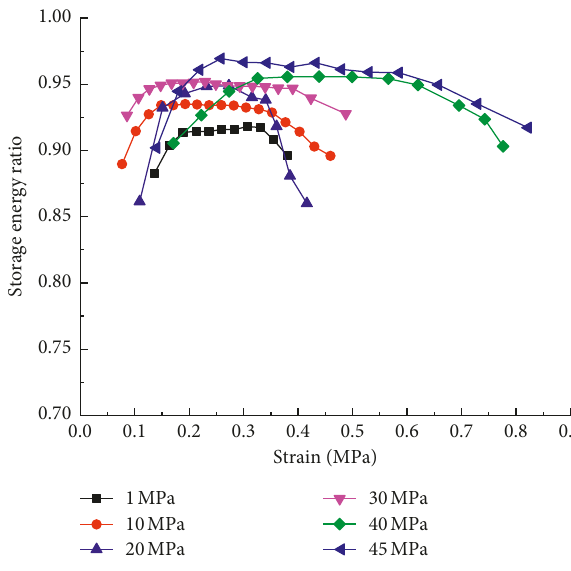
Figure 10: Storage energy ratio with strain.